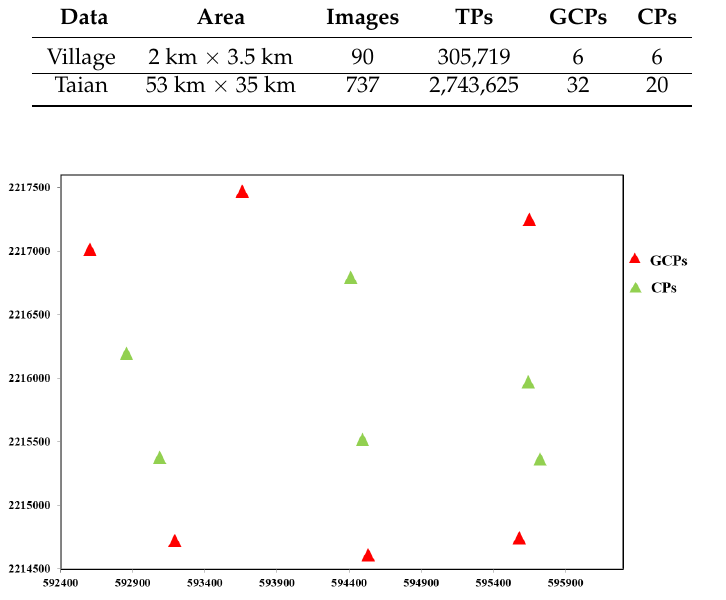
Figure 6. Distribution of the GCPs and CPs for the Village data.